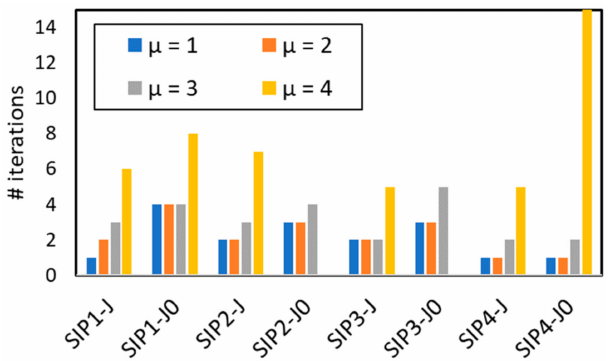
Figure 12. Total iterations employed in case_ieee30 with different solvers and various R/X ratios.